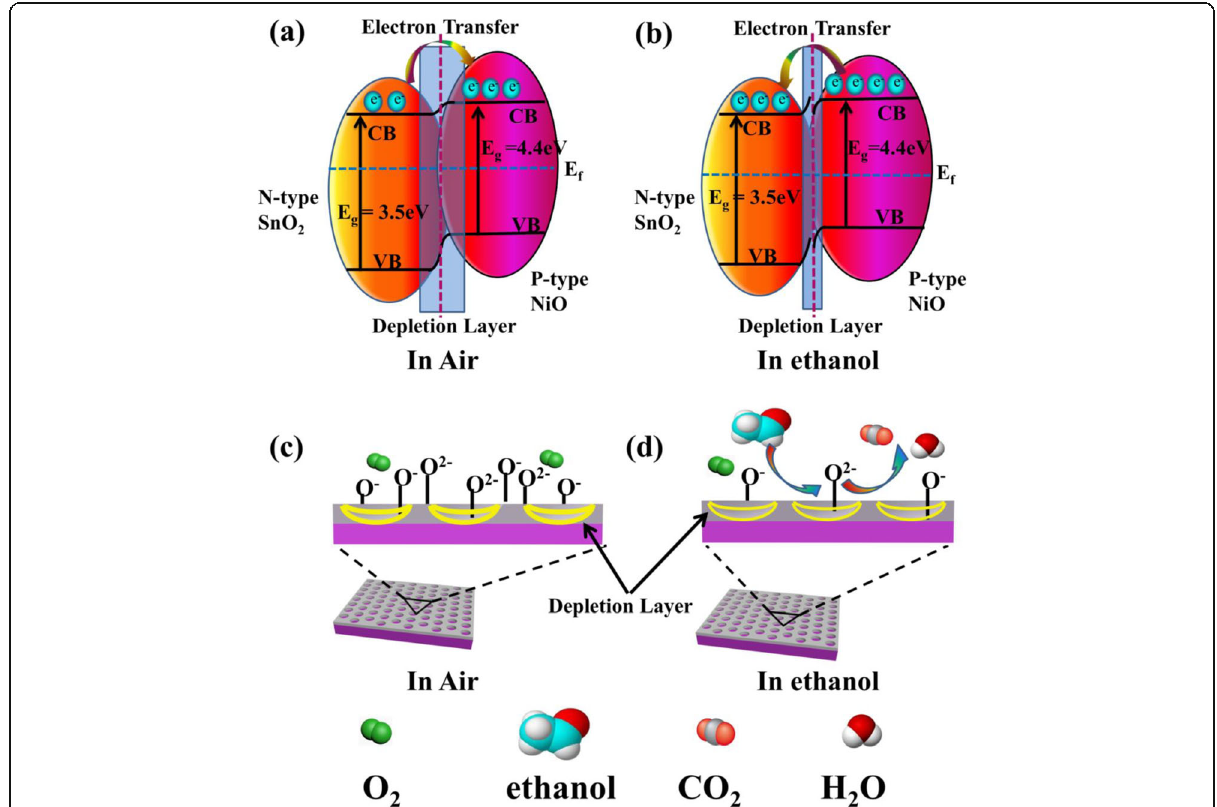
Fig. 8 Schematics diagram of gas-sensing mechanism of cross-linked SnO 2 :NiO network. a , b Schematic diagram of the energy band configurations for SnO 2 :NiO network in air and in ethanol vapor. In the diagram, CB is the conduction band, VB is the valence band, E g is the band gap, E f is the Fermi level, and e − is the charge of an electron. The depletion layers at the SnO 2 /NiO interface are indicated by blue rectangles. c , d Schematic model showing the sensing mechanism of the SnO 2 :NiO network exposed in air and ethanol, respectively. The yellow lines indicates the wide depletion region in the holes of cross-linked SnO 2 :NiO